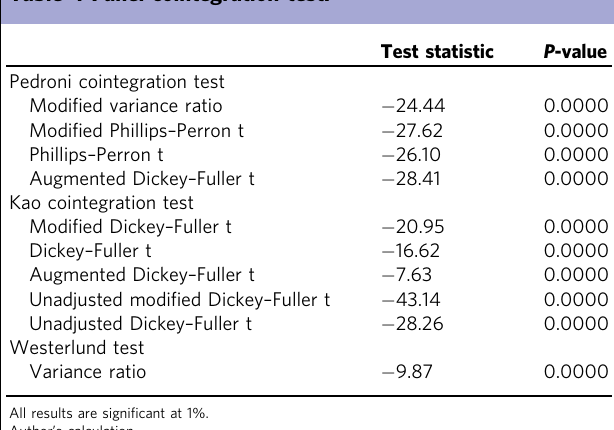
Table 4 Panel cointegration